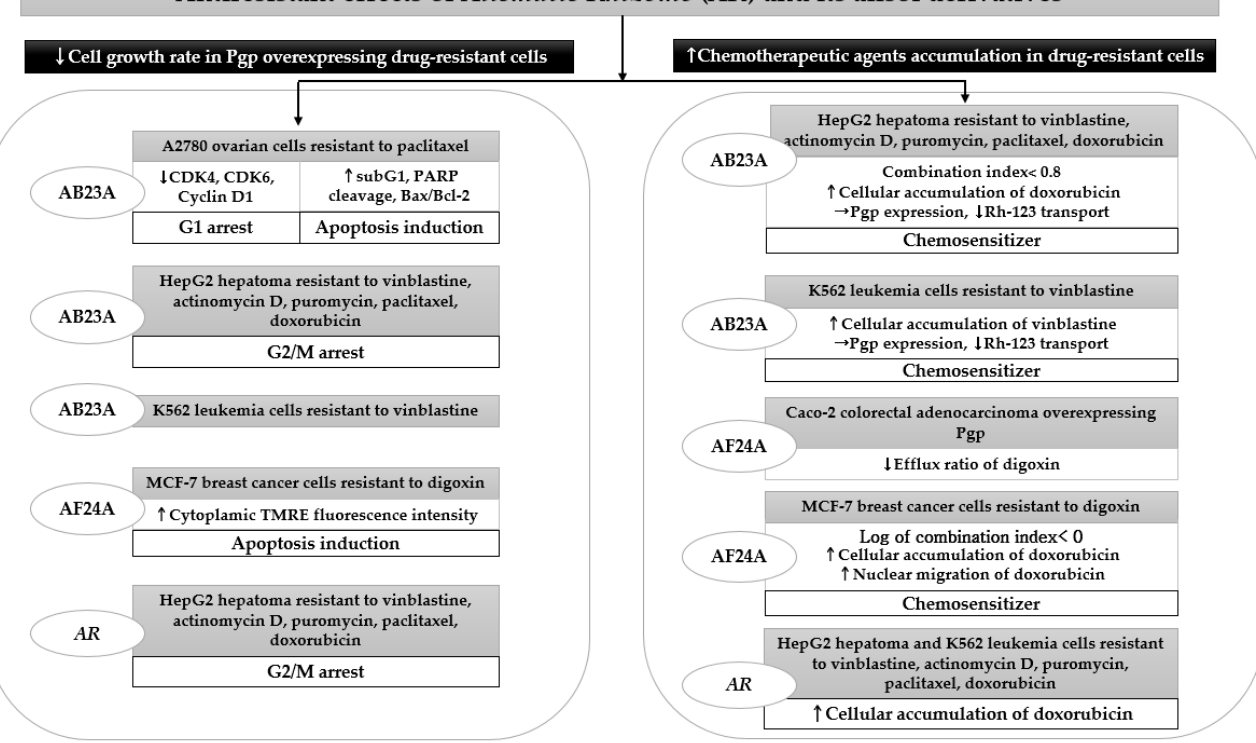
Figure 3. Antiresistant effects of AR and its triterpenes in drug-resistant cancer cells: AB23A, alisol B 23-acetate; AF24A, alisol F 24-acetate; AR , Alismatis rhizome ; CDK, cyclin-dependent kinase; Bax: Bcl2-associated X protein; Bcl: B-cell lymphoma; Rh-123, rhodamine 123; Pgp, p -glycoprotein. Upward pointing arrows ( ↑ ) and downward pointing arrows ( ↓ ) indicate an increase or a decrease in a numerical value, rate, change, or degree, respectively.